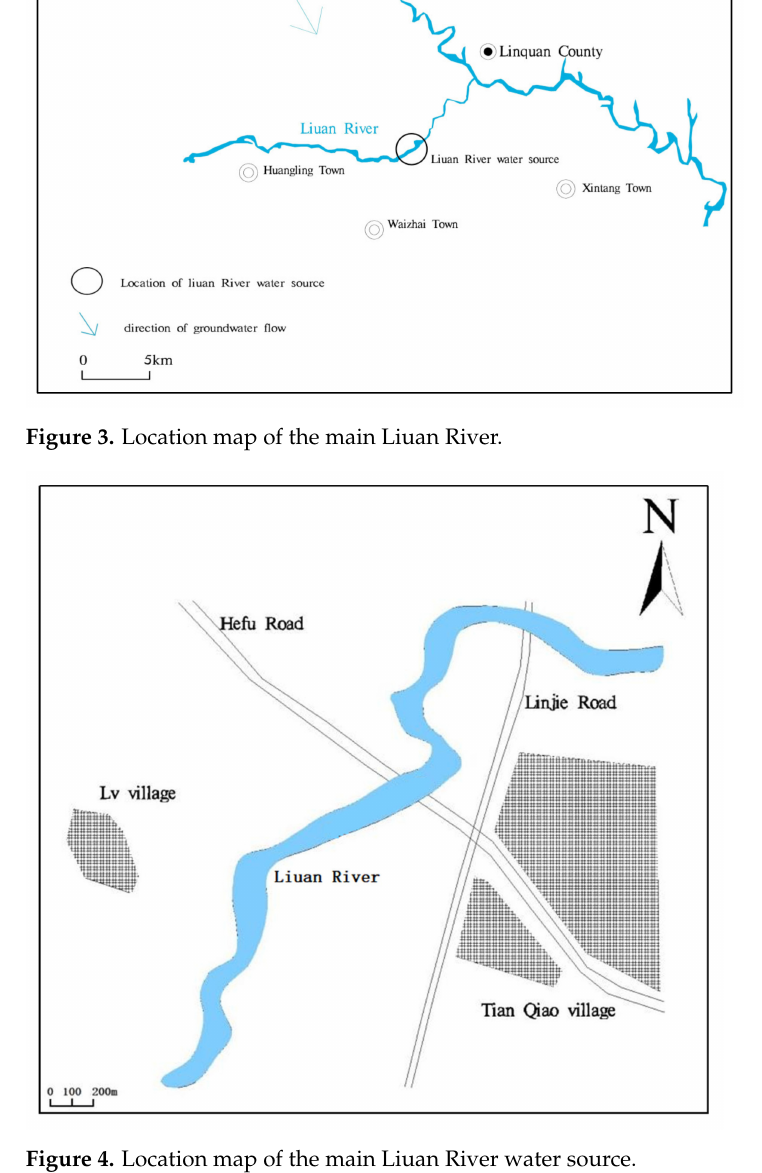
Figure 4. Location map of the main Liuan River water